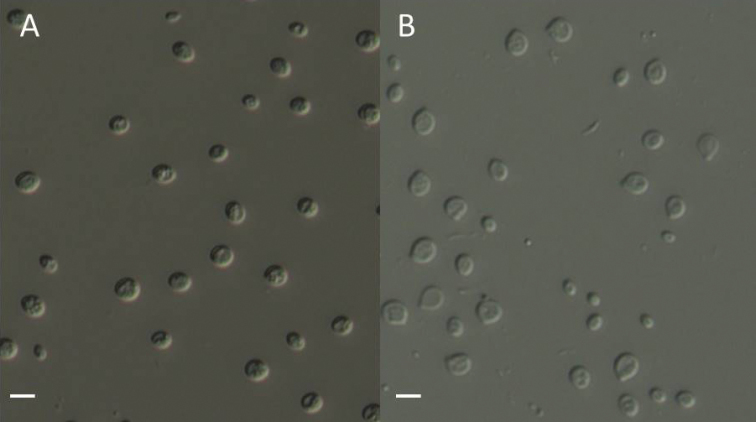
TremellabasidiomaticolaCGMCC 2.5724TA Vegetative cells grown in YM agar for 7 days at 17 °C B Ballistoconidia produced on CMA agar for 7 days at 17 °C. Scale bars: 5 μm.